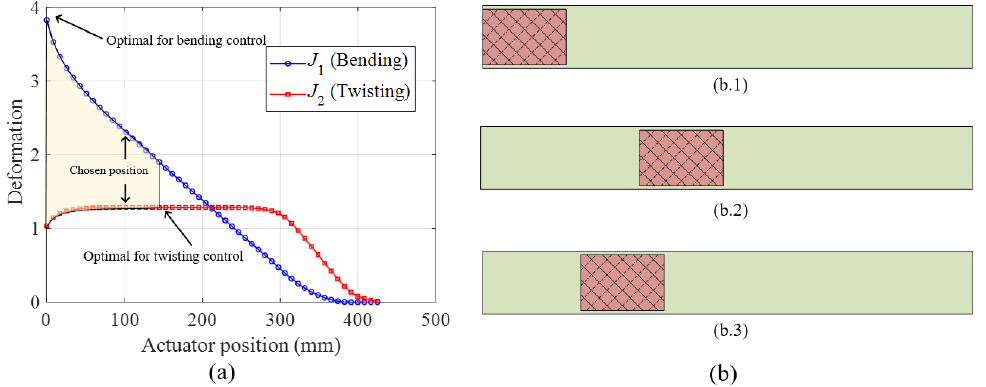
Figure 3. Variations in the bending and twisting deformations with the position of the actuator: ( a ) The variations in the bending and twisting deformations with actuator position; ( b.1 ) the best position for bending control; ( b.2 ) the best position for twisting control; ( b.3 ) the chosen position for multi-mode shape control.